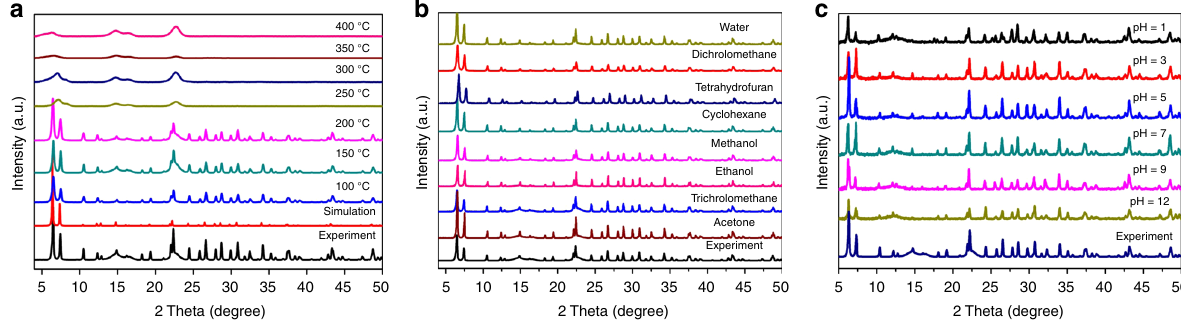
Fig. 2 The PXRD patterns of Azole-Th-1 samples. a Thermal stability from 100 to 400 °C, including simulated and experimental results, b soaking in water and seven different organic solvents 30 days, and c soaking in different pH solvents 30 days. Source data are provided as a Source Data fi le.